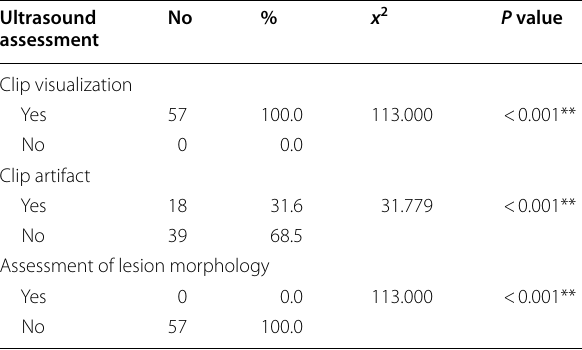
Table 1 Post-placement ultrasound clip assessment among study group